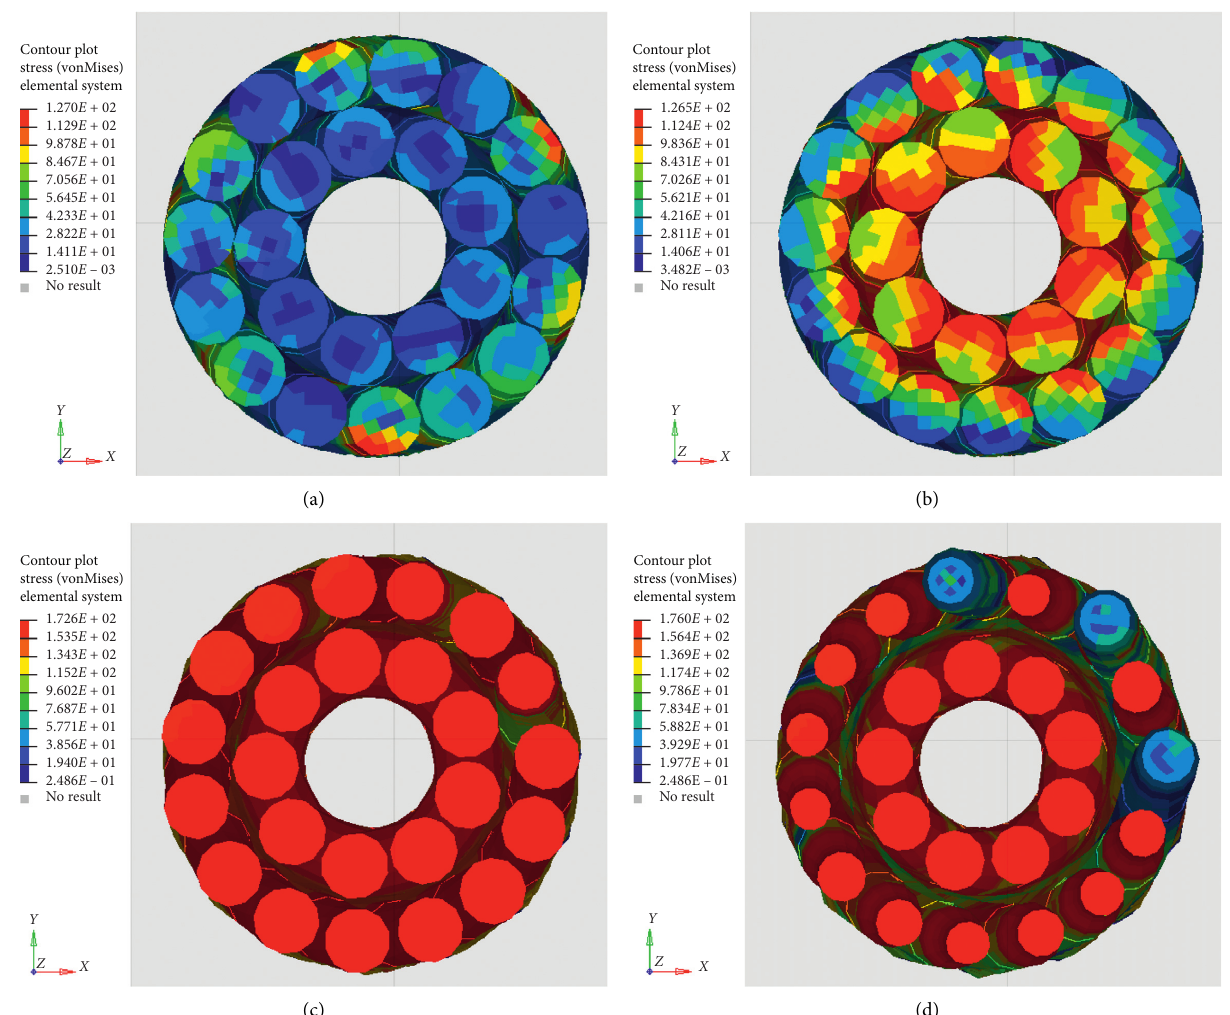
Figure 16: Stress nephograms of the cross section of the aluminum strand at the fracture location under different tensile loadings: (a) 25% RTS; (b) 50% RTS; (c) 95% RTS; (d) ultimate